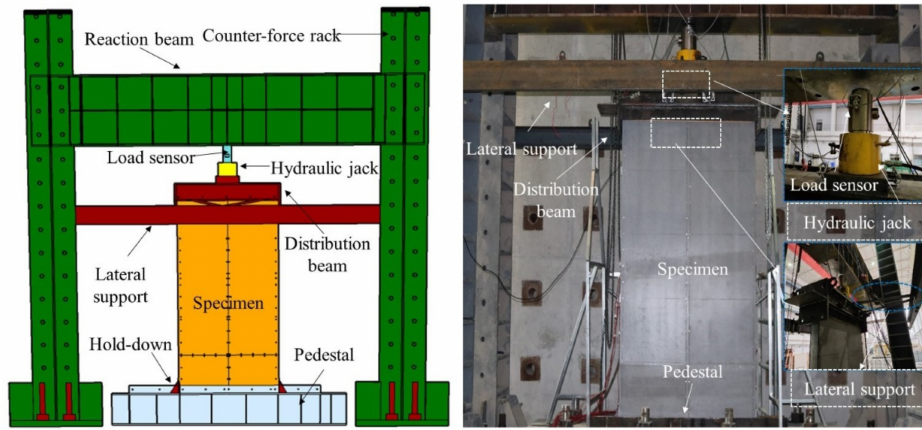
Figure 3. Test loading device.